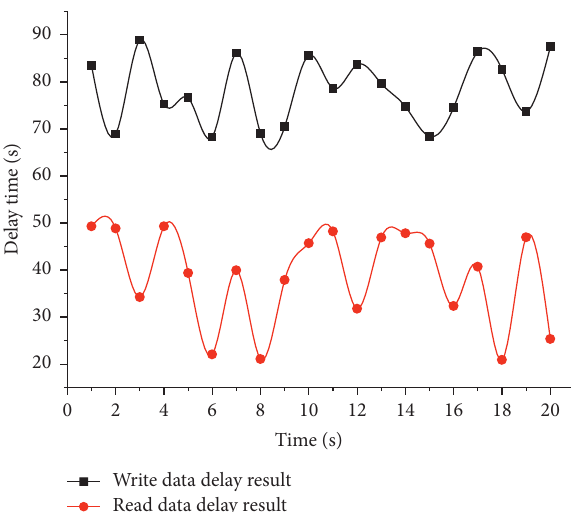
Figure 6: Average read/write latency comparison